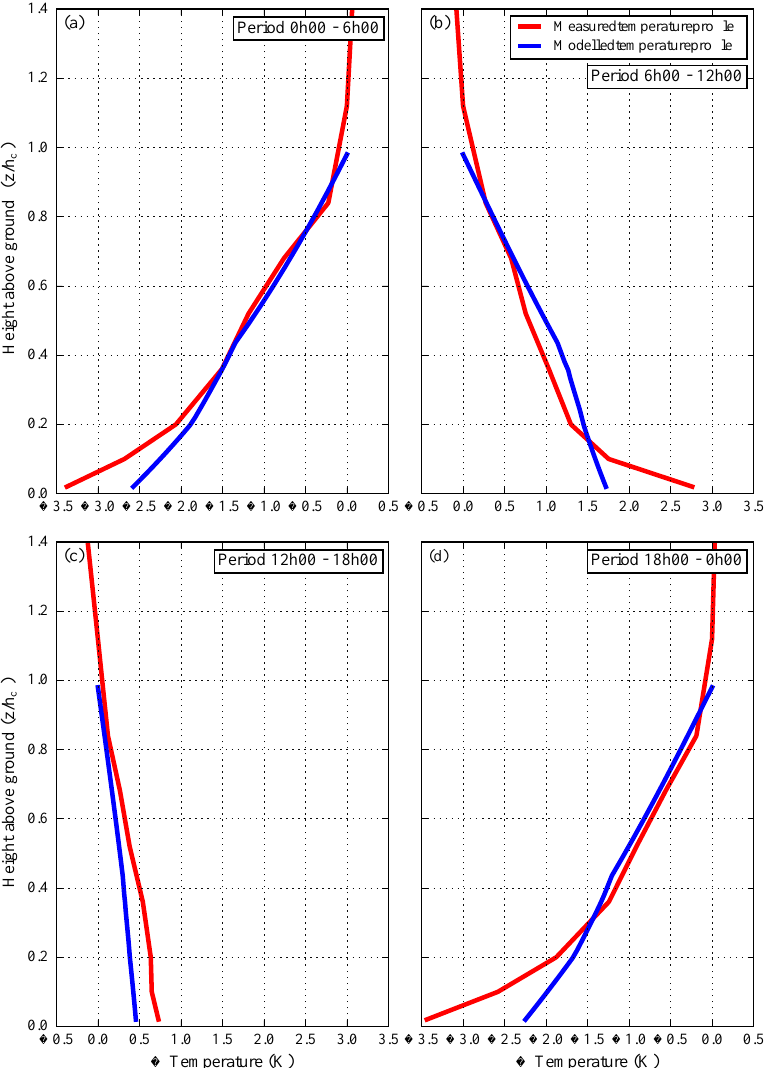
Figure 7. Vertical within-canopy temperature profiles for four 6h periods corresponding to the same time period as in Fig. 6. Mean modelled temperature profiles (blue) within the canopy against the measured temperature profiles (red) for the local time periods: (a) 00:00–06:00; (b) 06:00–12:00; (c) 12:00–18:00, and (d) 18:00–00:00LT, both expressed as a difference from the temperature at the top of